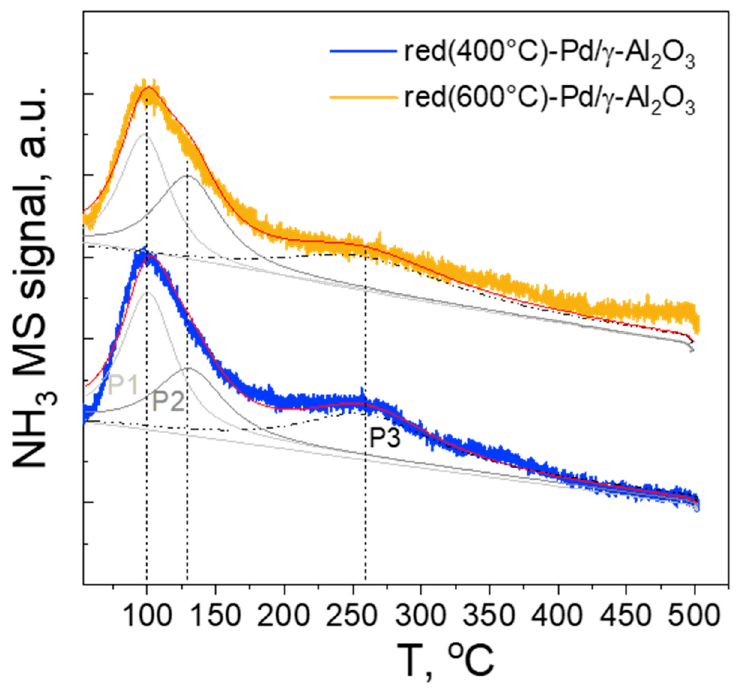
Figure 8. NH 3 Temperature-Programmed Desorption (NH 3 -TPD) profiles of red(400 °C)-Pd/ γ - Al 2 O 3 and red(600 °C)-Pd/ γ -Al 2 O